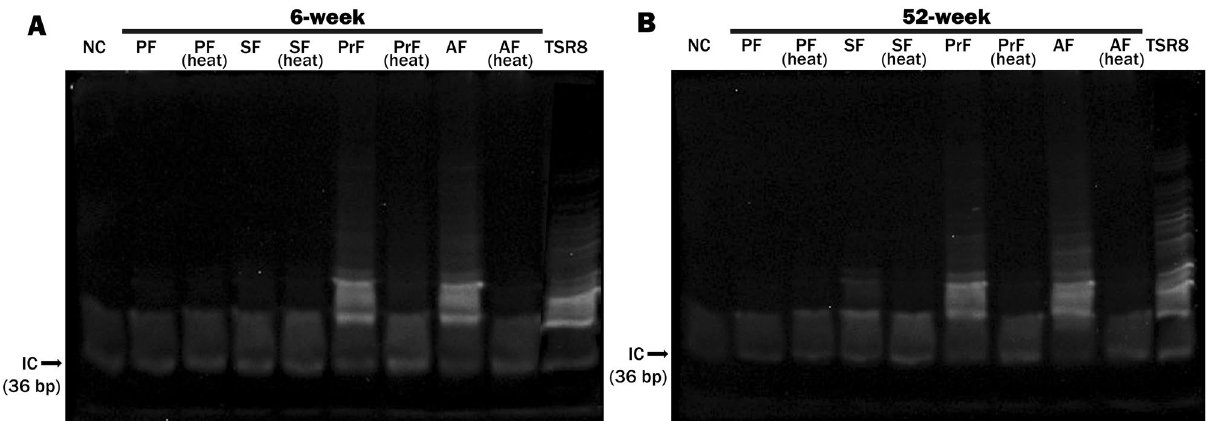
Figure 4. The telomerase activity in the ovarian follicles from primary to antral stages, obtained from adult (6-week-old) and aged (52-week-old) groups. For this analysis, we used primary (n = 34 and 21), secondary (n = 30 and 46), preantral (n = 30 and 25), and antral (n = 30 and 25) follicles collected from five adult and three aged mice, respectively. The TRAP assay results of the follicles from primary to antral stages in the adult ( A ) and aged ( B ) groups. As expected, internal control (IC) product was generated in all reaction tubes. An additional heat-treated control (abbreviated as heat) was run alongside each sample as telomerase is a heat-sensitive enzyme. In both adult and aged groups, we found that telomerase activity reached high levels in the preantral and antral follicles when compared to the primary and secondary follicles. It is worth noting that that this assay was technically repeated twice. NC negative control, PF primary follicles, SF secondary follicles, PrF preantral follicles, AF antral follicles, TSR8 control template, bp base that pregnant mare’s serum gonadotropin [PMSG, 10 IU/mL; an FSH (follicle stimulating hormone) analog], enhanced TERT protein and mRNA levels as well as telomerase activity in the rat granulosa cells 42 . Overall, these findings suggest that the fluctuating Tert gene expression in the follicles during aging may arise from altered estradiol and FSH levels as well as from changes in their receptors. We also observed that the relative levels of Trf1 , Trf2 , and Pot1a mRNAs in the antral follicles predominantly decreased in the aged group. As the late stages of folliculogenesis including preantral and antral follicles occur in a gonadotropin-dependent manner 43 , the decreased expression of these genes may be associated with altered gonadotropins and/or their receptor profiles during biological aging. Interestingly, the secondary follicles from the aged group displayed higher Trf1 , Trf2 , and Pot1a mRNA levels as well as increased Tert and Terc gene expression compared to those from the adult group. This surge may have originated from increased or decreased amounts of the factors that stimulate transcriptional activity of these genes in the secondary follicles from the aged group. In more detail, changed expression of several genes in the aged secondary follicles 44 may lead to transcriptional stimulation via increasing transcriptional activators that might result in an increased expression of these telomere-related genes. Another possible reason of this increase may be arisen from enhanced FSH level in the aged mice 45 . As FSH is associated with increasing transcriptional activity 46,47 , the same effect might have occurred in the secondary follicles for these genes. Thus, as the mechanisms underlying the expressional control of telomere-related genes in mammalian follicles remain unknown, further studies are required to define those determinants. Similar to our findings, Russo et al. reported that TERT protein was detected in the primary and preantral follicles (both in the granulosa cells and oocytes), and in the antral follicles (in the granulosa cells close to the antrum and cumulus cells, as well as in the oocytes) from pig ovaries 29 . Additionally, a correlation was established between telomere sizes and TERT protein levels in these follicles. Different from our finding, Lavranos et al. also measured the telomerase activity using PCR-ELISA method and observed a higher telomerase activity in the preantral follicles (60–100 µm in diameter) compared to that in small antral follicles (1 mm in diameter) from bovine ovaries 28 . This difference may arise from employing distinct methods, and the species being studied. Also, germinal vesicle (GV) oocytes in the human follicles at different developmental stages displayed higher telom- erase activity than in the MII oocytes 48,49 . In rats, GV (from preantral and antral follicles) and MII oocytes also exhibited telomerase activity 27 . We revealed in the present study that telomerase activity levels sharply increased in the antral follicles in both adult and aged groups, possibly dependent on the granulosa cell content, and cyto- plasmic and nuclear maturation status of the oocytes. The contrasting results regarding the TERT protein levels and telomerase activity in the follicles may be due to other potential roles of the TERT protein 50 in the granulosa cells and oocytes during folliculogenesis. In the present study, we determined that telomerase activity significantly increased in the preantral and antral follicles of the adult and aged groups compared to those of early follicles. As estradiol production increases in these follicular stages 51,52 , the increase of telomerase activity may derive from elevated estradiol levels. As previ- ously described, estradiol leads to an increased Tert gene expression 39 , and expectedly estradiol deficiency can reduce telomerase activity and telomere length in the mouse ovaries. On the other hand, the telomerase activity distribution in the mouse ovarian follicles from primary to antral stages contradicts with the previous studies which have been comprehensively discussed in the review article published by our group 11 . We observed that